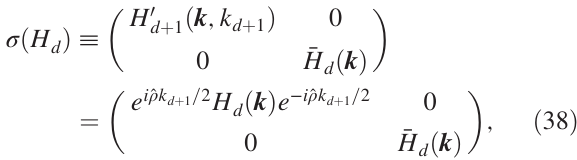
is the crystal- n